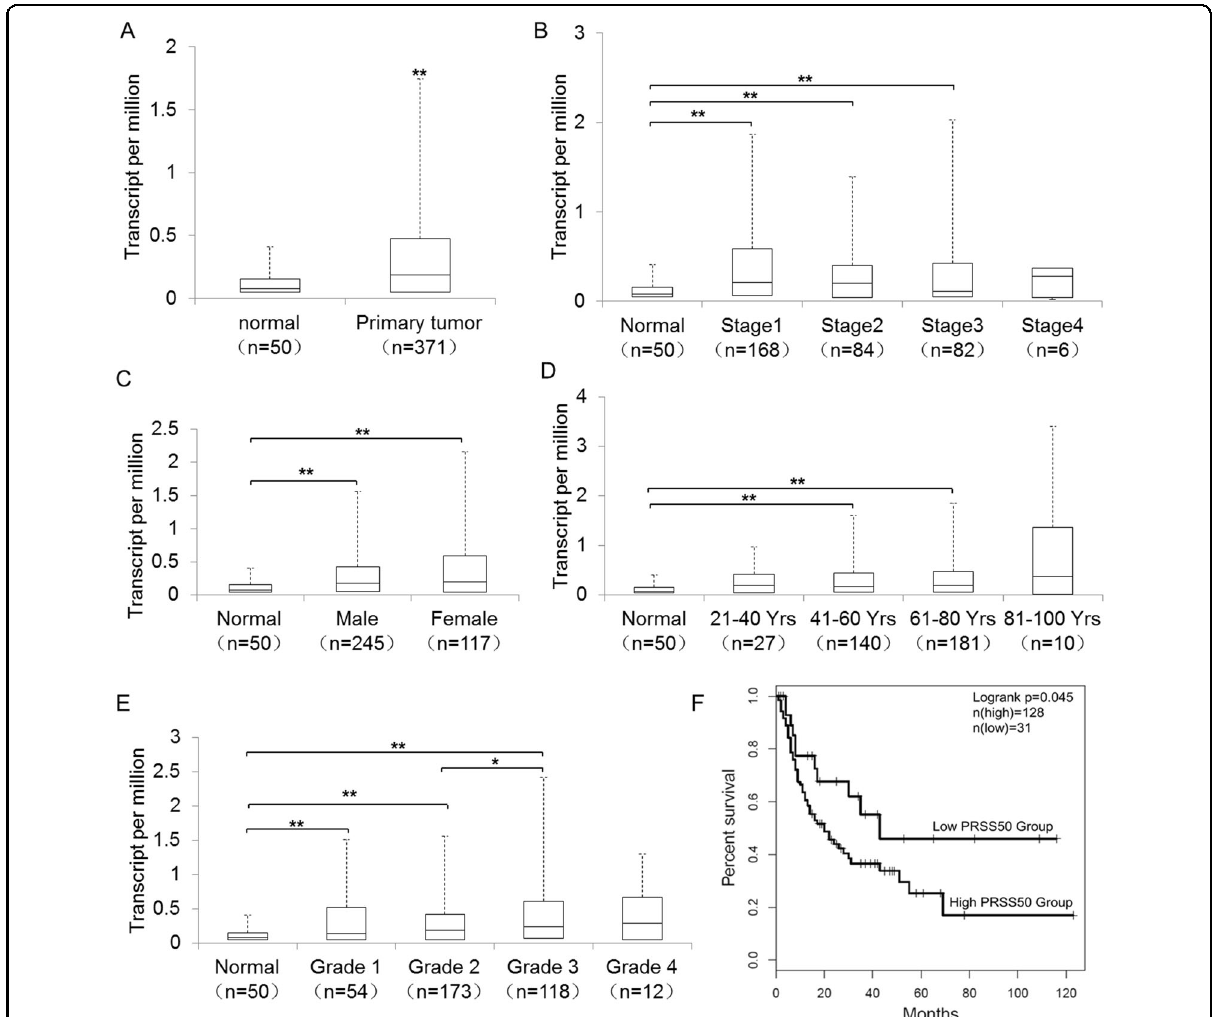
Fig. 1 TSP50 is elevated in HCC and survival-associated. A Boxplot showing relative expression of TSP50 in normal and HCC samples. B Boxplot showing the relative expression of TSP50 in normal individuals and HCC patients in different stages. C Boxplot showing the TSP50 relative expression in normal individuals as well as male and female HCC patients, respectively. D Boxplot showing relative expression of TSP50 in normal individuals of any age and LIHC patients aged 21 – 40, 41 – 60, 61 – 80, or 81 – 100 yr. E Boxplot showing the TSP50 relative expression in normal individuals and HCC patients with grade 1, 2, 3 or 4 tumors. F GEPIA analysis of the correlation between TSP50 mRNA expression levels and RFS of HCC patients. A – E UALCAN database. F GEPIA database. The Student ’ s t -test was used to estimate the signi fi cance of difference between two groups and more than two groups were analyzed by one-way ANOVA. *P < 0.05 , ** P < 0.01